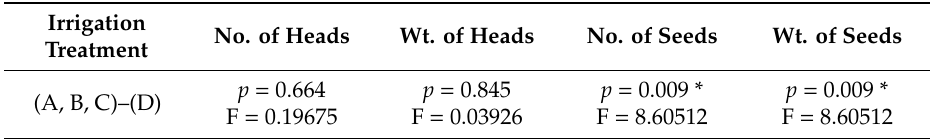
Table 10. Significance of the impact of full / reduced irrigation (A, B, and C) vs. deficit irrigation (D) on yield components of sunflower.